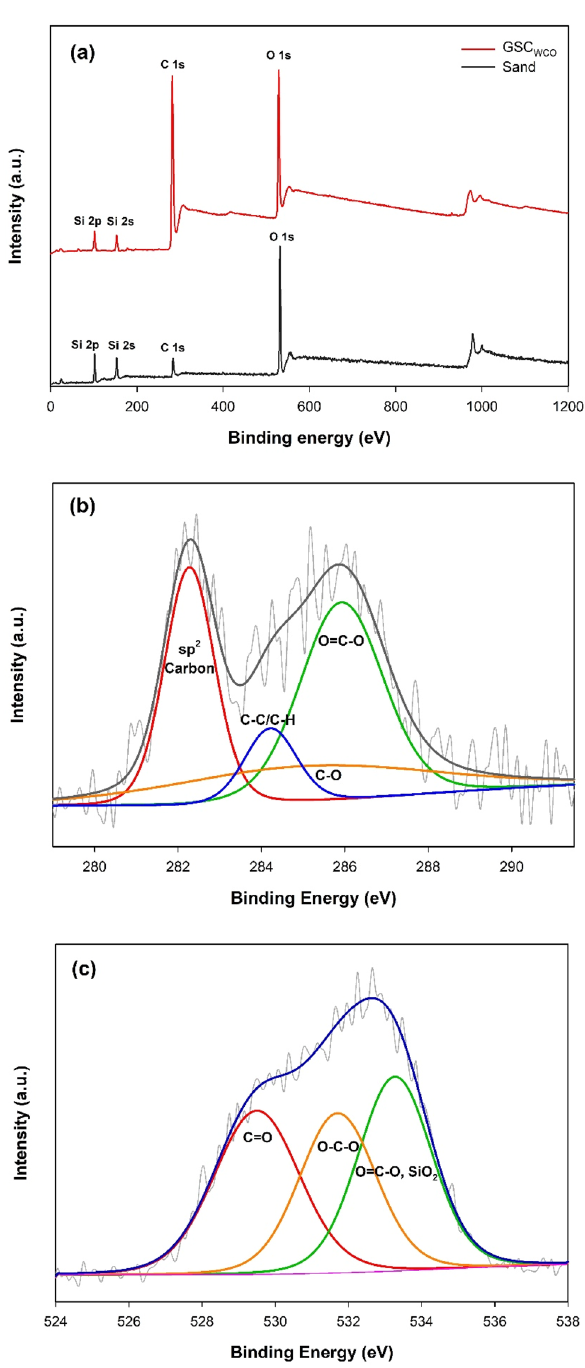
Figure 4. ( a ) XPS survey spectrum of sand and GSC WCO , ( b ) high-resolution GSC WCO spectra of C, ( c ) high- resolution GSC WCO spectra of